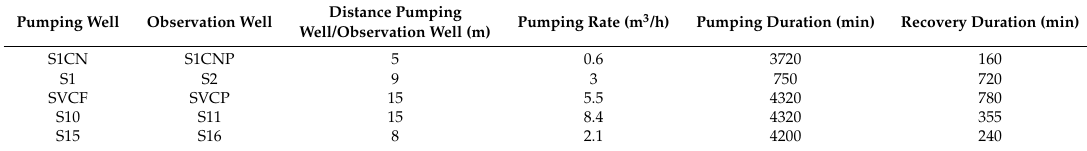
Table 1. Well test